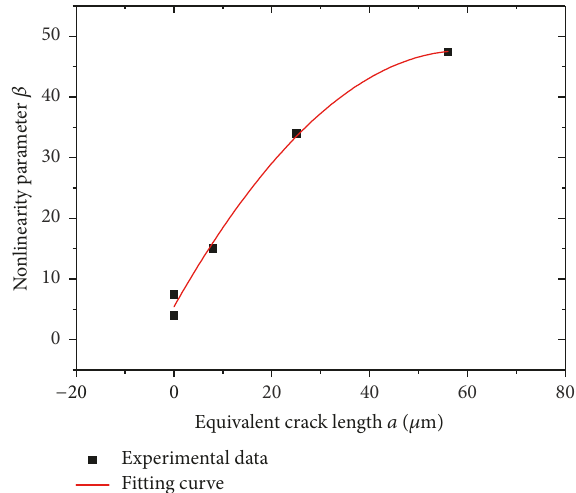
Figure 14: Relationship between equivalent crack length and non- linearity